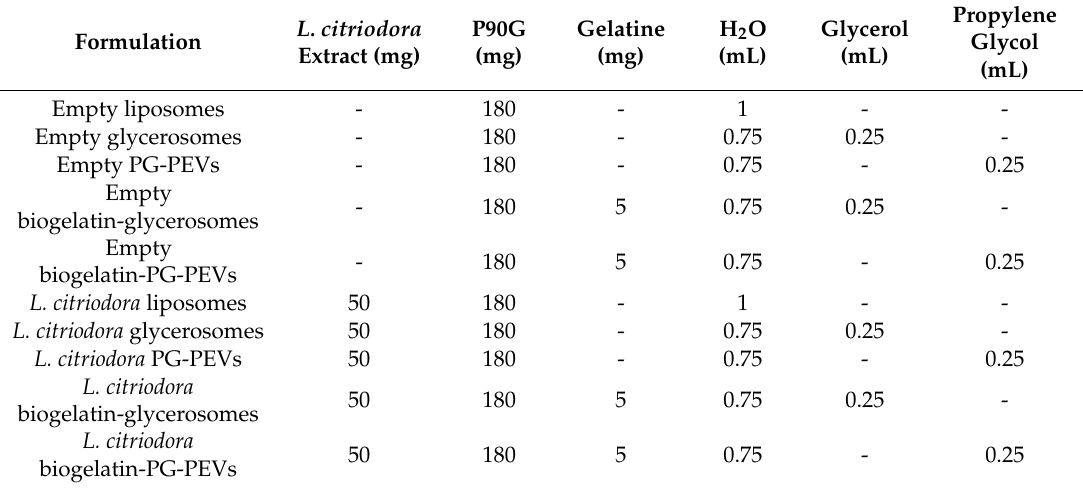
Table 1. Composition of the vesicle